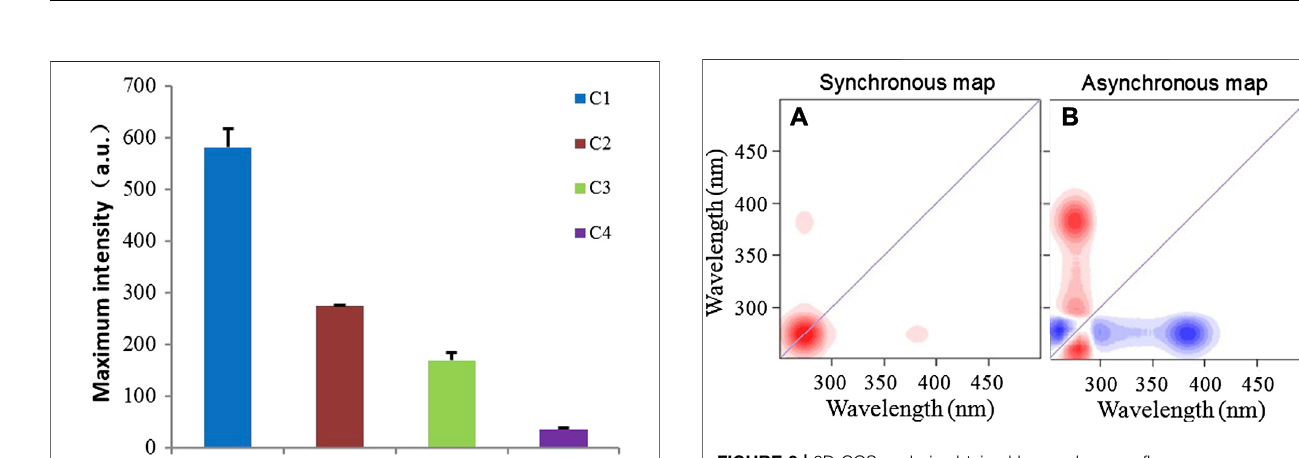
FIGURE 3 | 2D-COS analysis obtained by synchronous fl uorescence spectra. The red regions show positive correlations, and the blue regions show negative correlations. An increase in the intensity of a particular color represents a stronger positive or negative correlation. (A) : Synchronous map; (B) : asynchronous